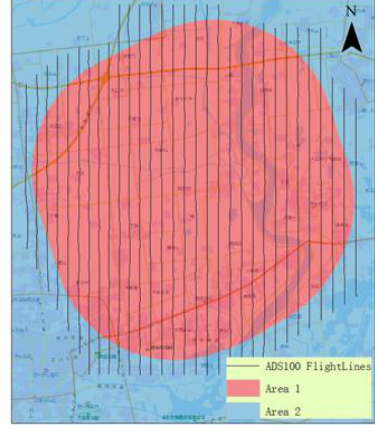
Figure 3. ADS100 flight lines